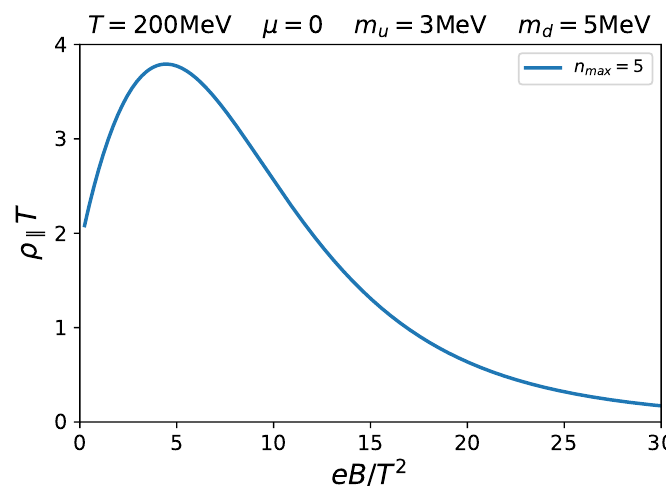
Figure 1 . Negative magnetoresistance; (cid:26) decreases with increasing magnetic (cid:12)eld eB . The k temperature is T = 200 MeV and the density is zero, and n max = 5 represents the highest Landau level taken into the